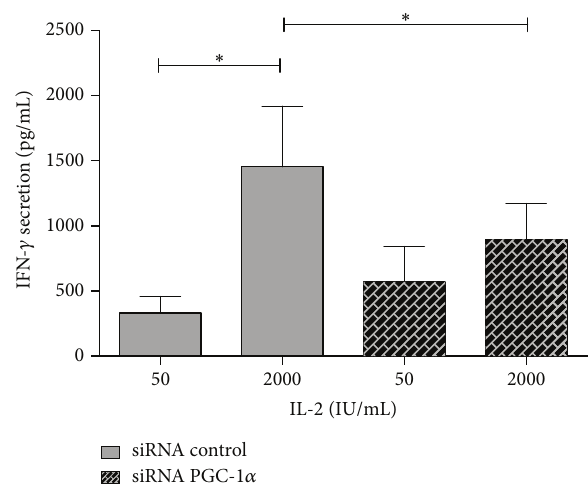
Figure 5: PGC-1 𝛼 upregulation is required for optimal secretion of IFN- 𝛾 production in human NK cells. Quantification of IFN- 𝛾 was performedbyELISA.PurifiedhumanNKcellsweretransfectedwith siRNA specific for PGC-1 𝛼 or negative control and then treated with 50 (control) or 2000 (activated) IU/mL of IL-2 for 72 h. Results show the mean of 5 independent experiments ± SE ( ∗ 𝑝 < 0.05